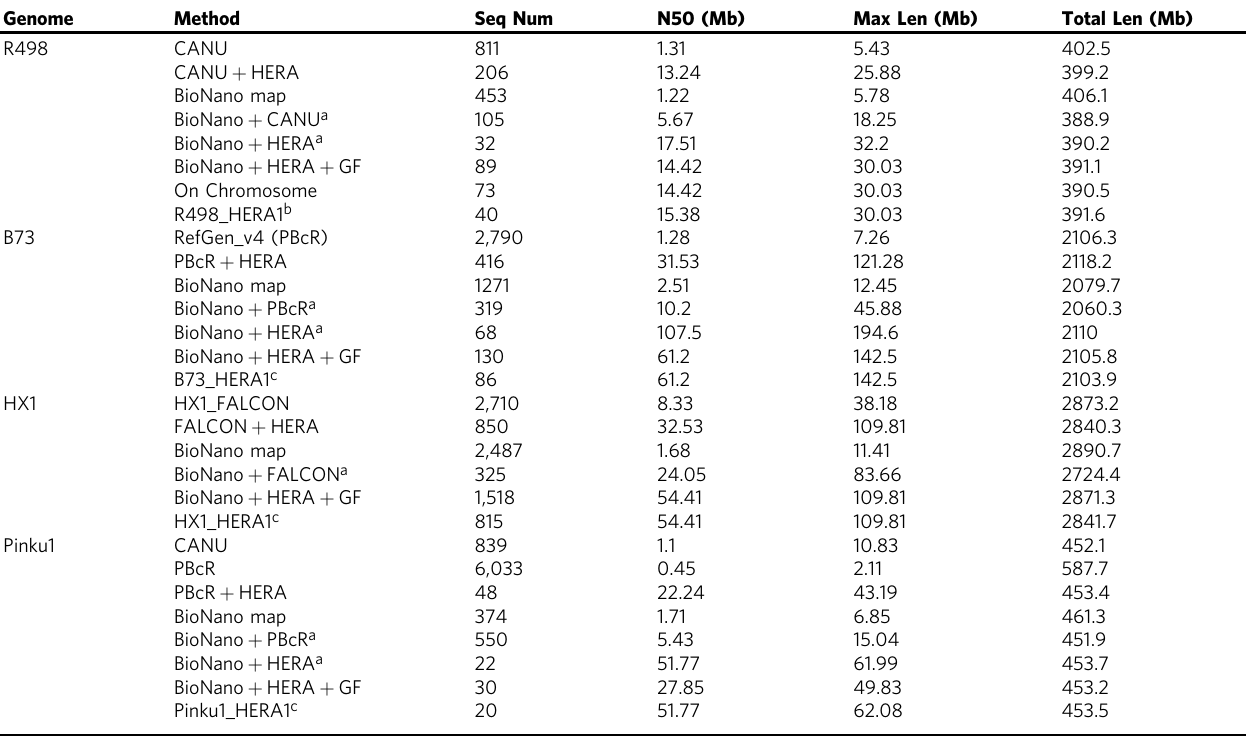
Table 1 The summary of genome assemblies.